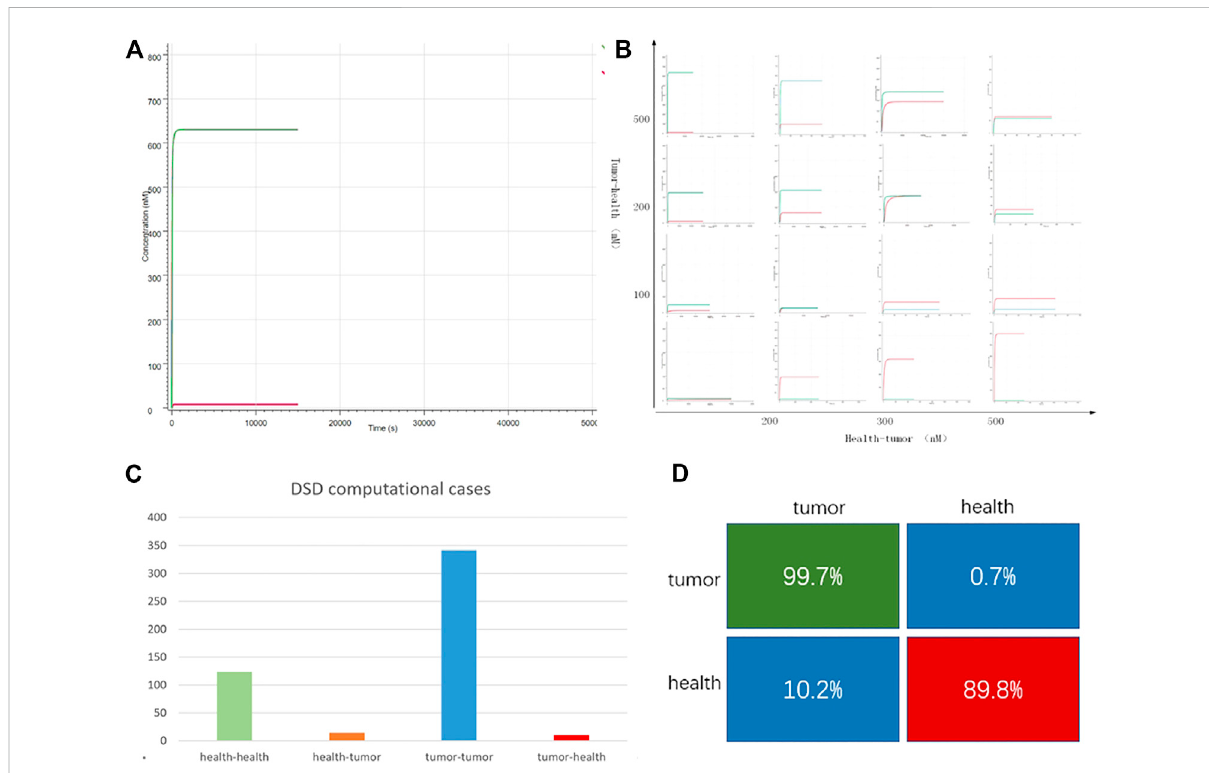
FIGURE 4 DNAcomputingresults. (A) Case “ TCGA-3M-AB46-01 ” : y -axisistheoutputstrand ’ concentration;the x -axisisthereactiontime.Thegreenline is the tumor group with FAM fl uorescent labels. The red line is the health group with ROX labeled. The green line is higher than the red line, which indicates, in this case, the tumor group predominates. (B) 16 typical cases. The whole 490 DSD computing results are attached in Supplementary Material S2. The x -axis represents the difference in the concentration of the input DNA strands, the y -axis indicates the difference in the fl uorescentintensityoftheoutputs (C) DSDsimulationresults,thereare138healthcasescomputedashealth,14healthcasescomputedastumor.In allthe353tumorcases,342caseswerecomputedastumor,and11caseswerecomputedashealth. (D) Thecomputationalaccuracyoftumorcases is 78.7%, while the accuracy of health cases is